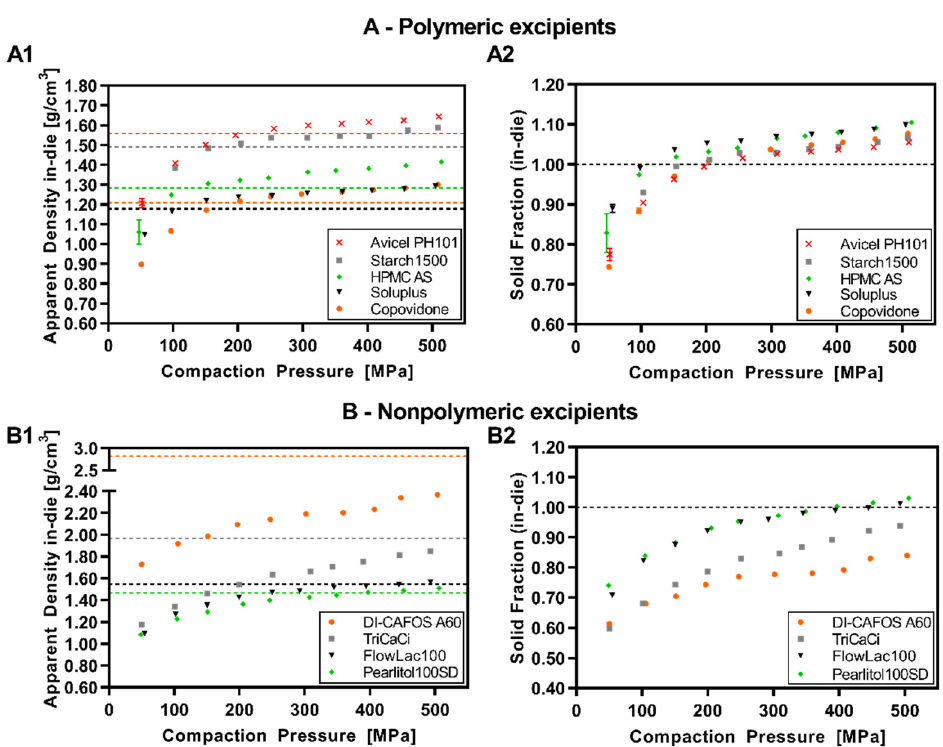
Figure 3. ( A ) Polymeric excipients: apparent density in ‐ die vs. compaction pressure (dotted lines = respective particle densities) ( A1 ); solid fraction in ‐ die vs. compaction pressure ( A2 ); ( B ) Nonpolymeric excipients: apparent density in ‐ die vs. compaction pressure (dotted lines = respective particle densities) ( B1 ); solid fraction in ‐ die vs. compaction pressure ( B2 ).